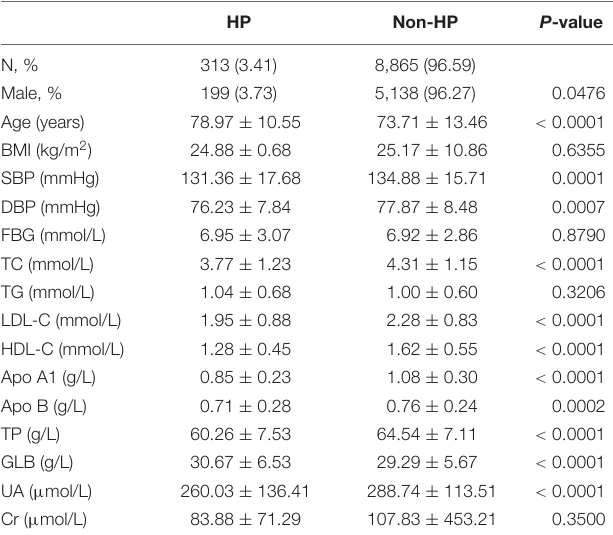
TABLE 1 | Characteristics of hypostatic pneumonia (HP) and non-HP participants in the cross-sectional